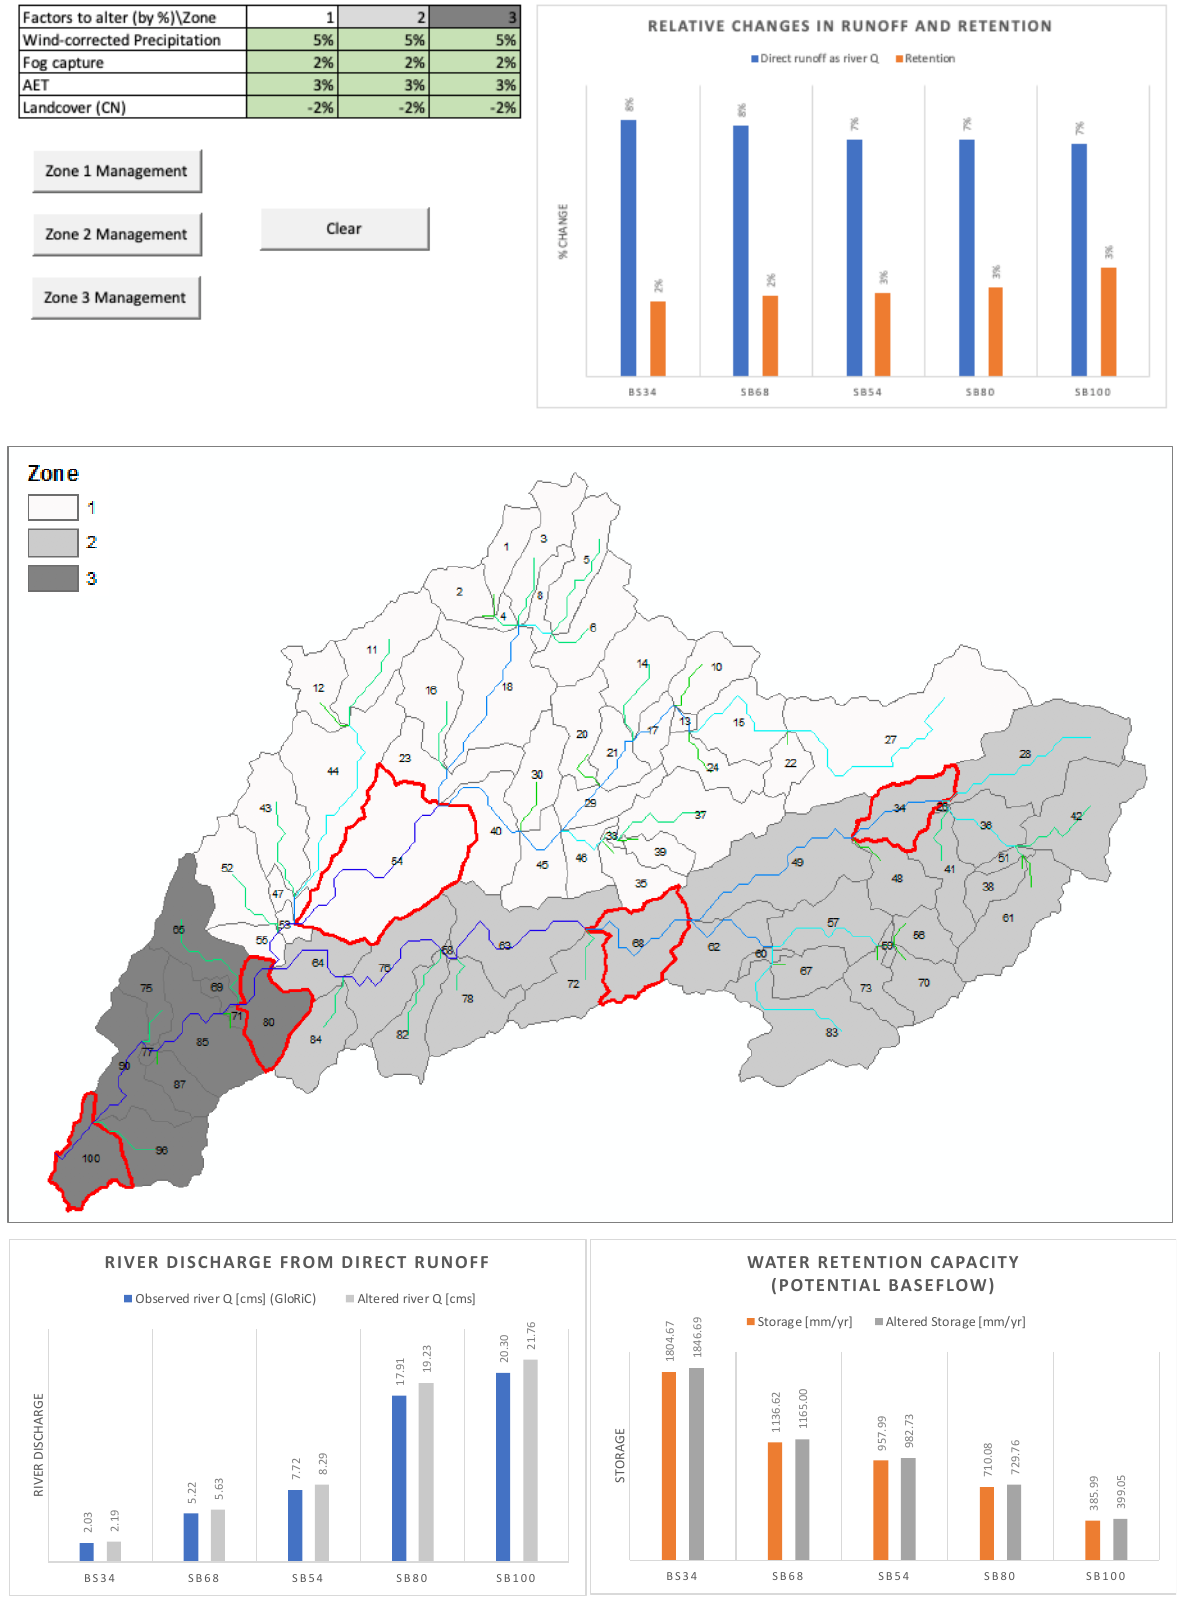
Figure A6. rcNEIS model interface showing example outputs in selected subbasins (outlined in red) illustrates how water is distributed across the